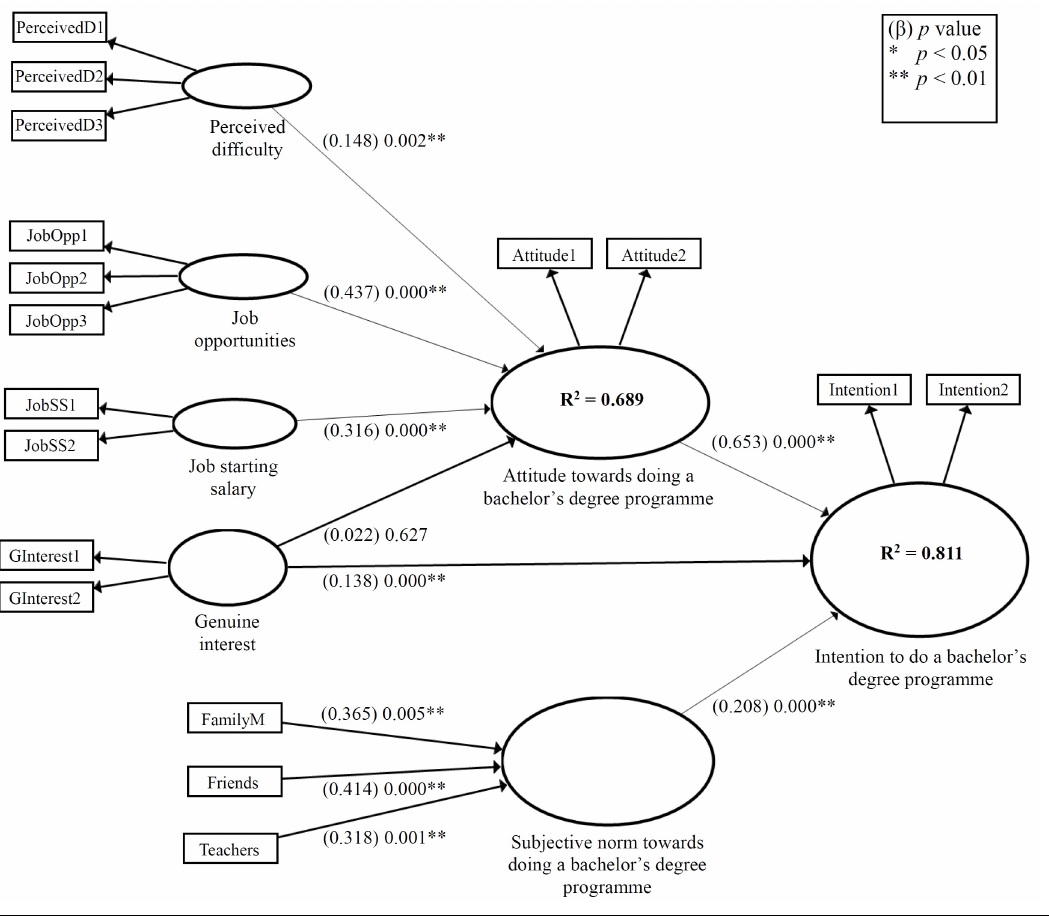
Figure 3. Structural equation modelling empirical results (Source: Authors,